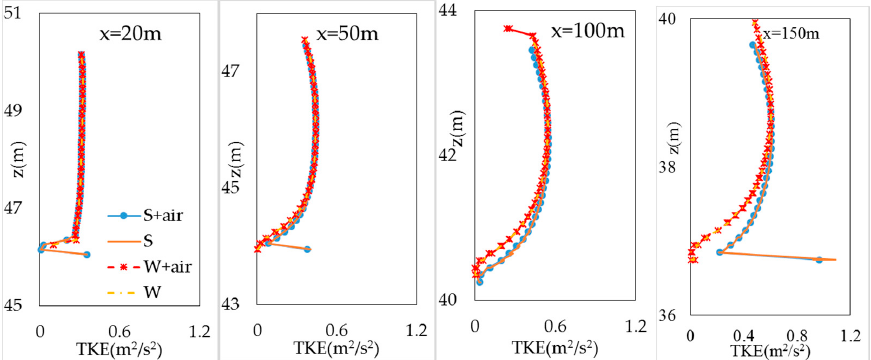
Figure 20. Turbulence kinetic energy (TKE) estimated with and without the air entrainment model in cases with wall (W) and step (S) abutments when Z up = 55.86 m.